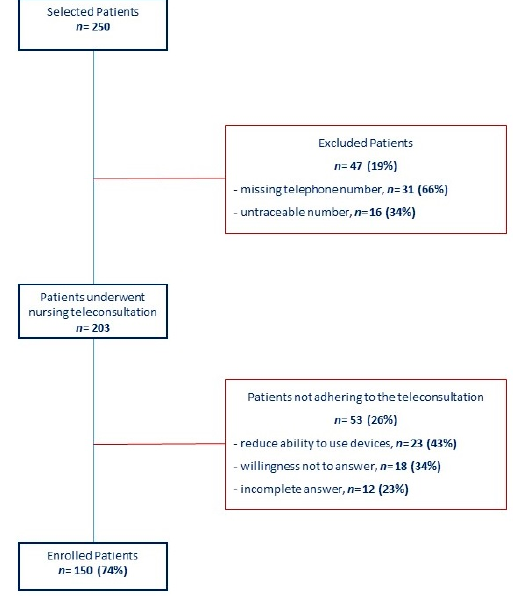
Figure 1. Inclusion graph of the study population. Table 1. Clinical characteristics of the study population ( n : 150) according to the need (intervention group) or not (target group) of medical intervention following nursing teleconsultation.